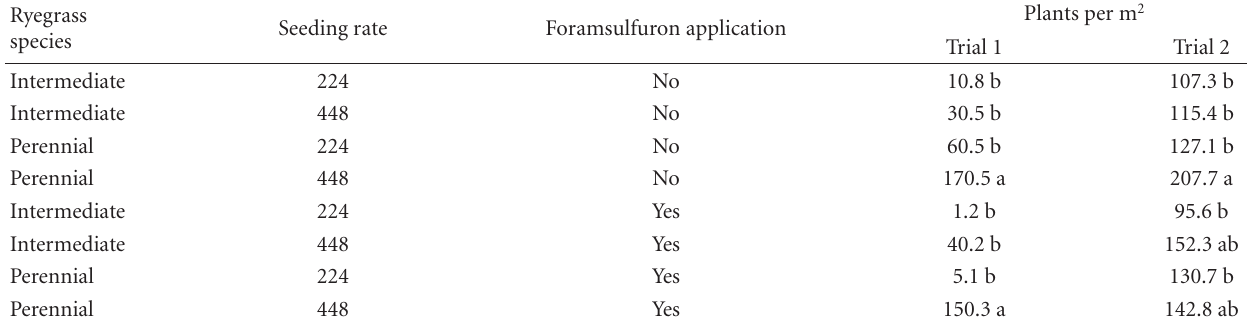
Table 3: Persistence of two ryegrass species one year after seeding as a ff ected by herbicide application in 2004 and 2005 for the first ex- periment.